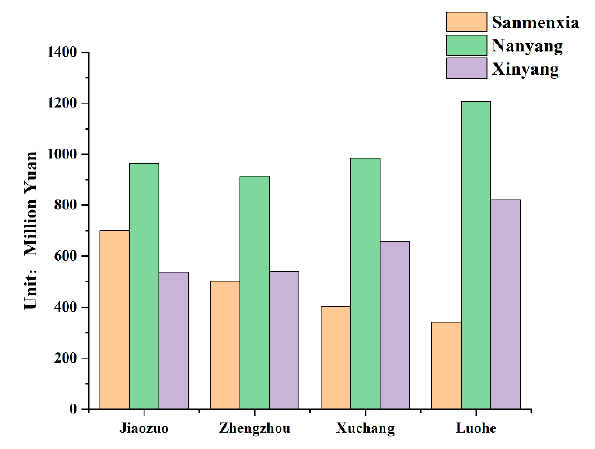
Figure 7. Ecological compensation fund paid by each ECPA.